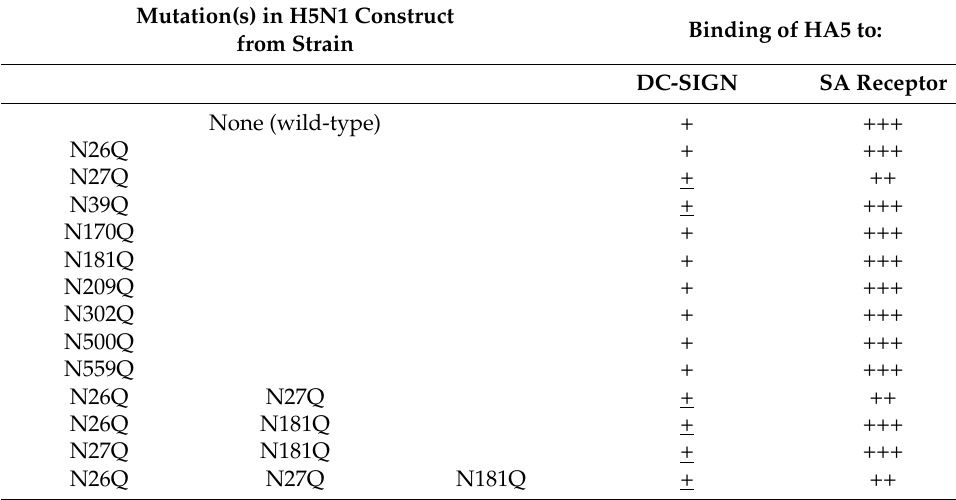
Binding of HA5 to: DC-SIGN SA Receptor